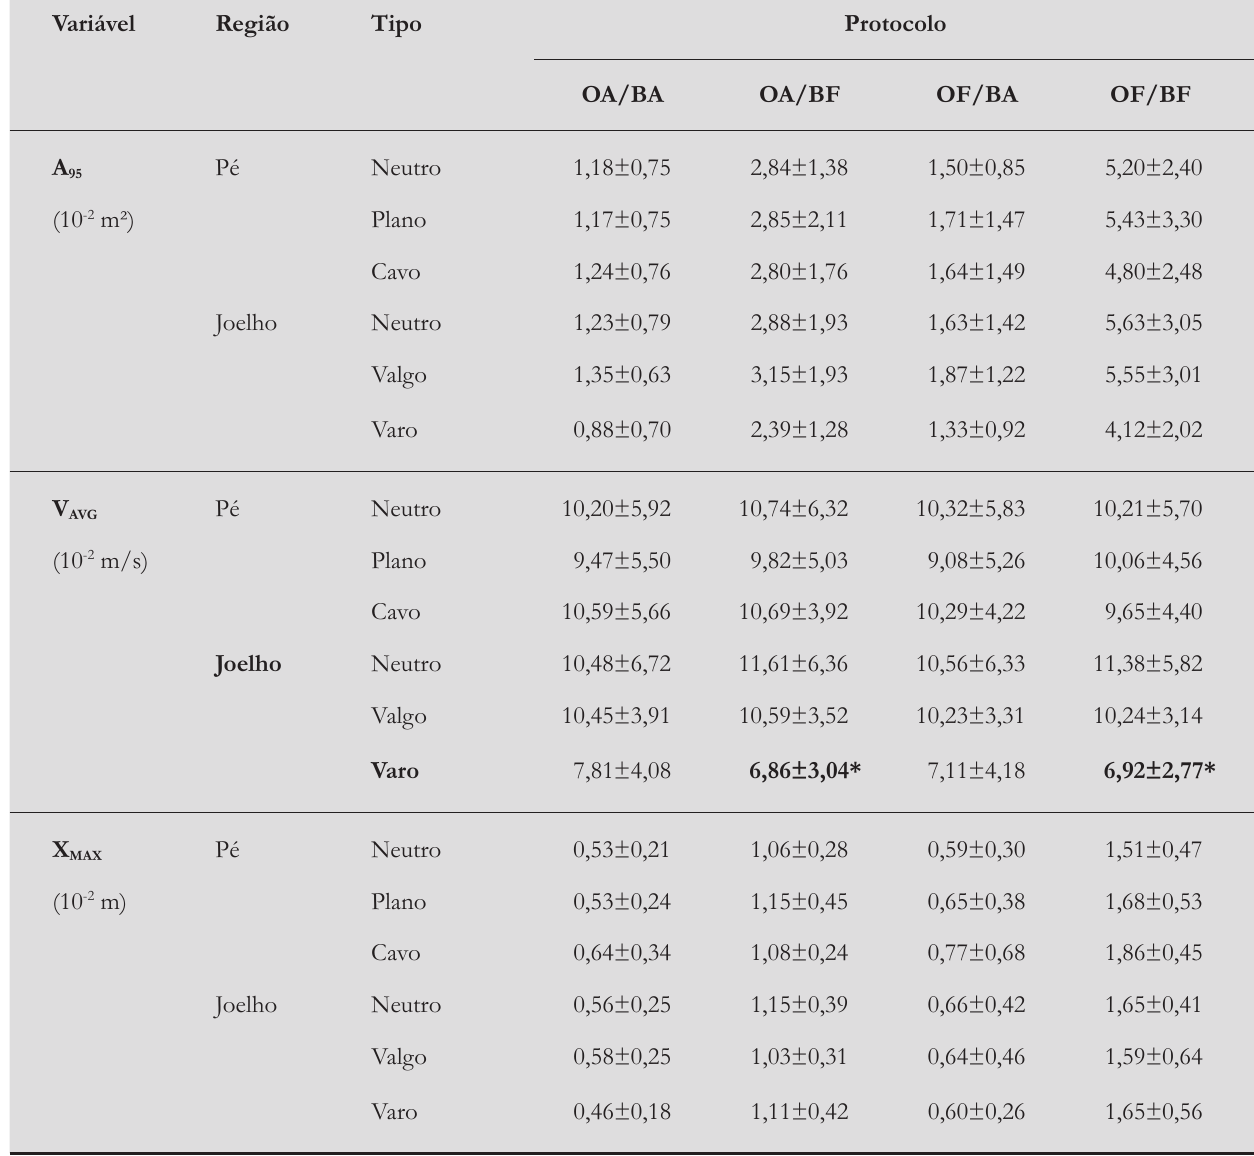
Tabela 1 - Variáveis estabilométricas calculadas por protocolo e agrupadas por morfologia de pés e joelhos